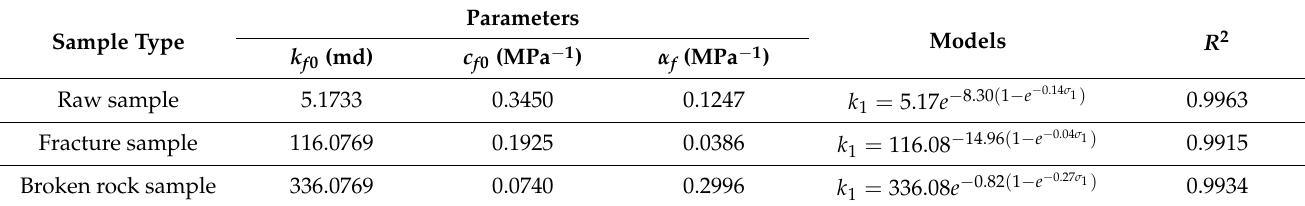
Table 1. Laboratory test results of different permeability models.